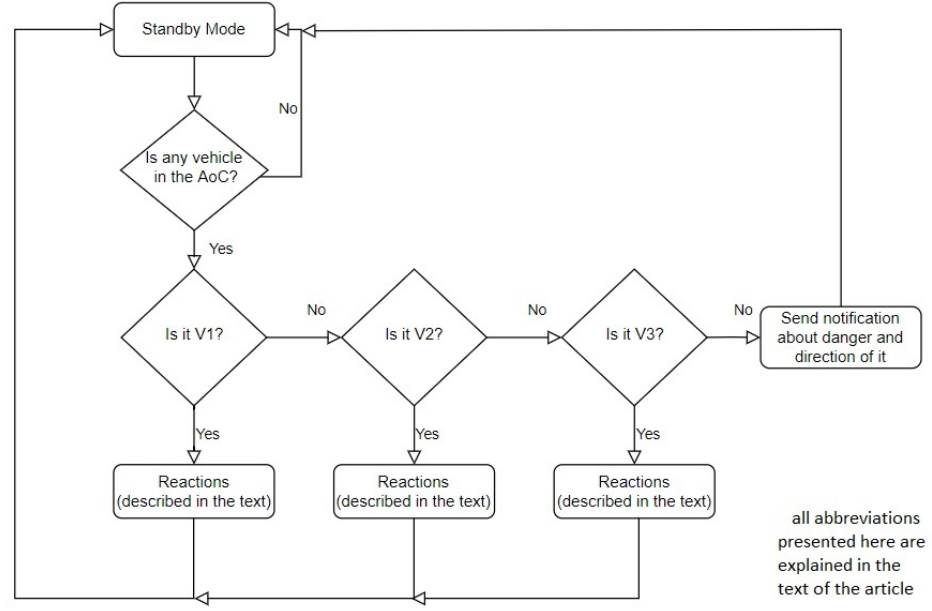
Figure 2. The algorithm for case 1: Obstructions on the road caused by maintenance works or other factors.